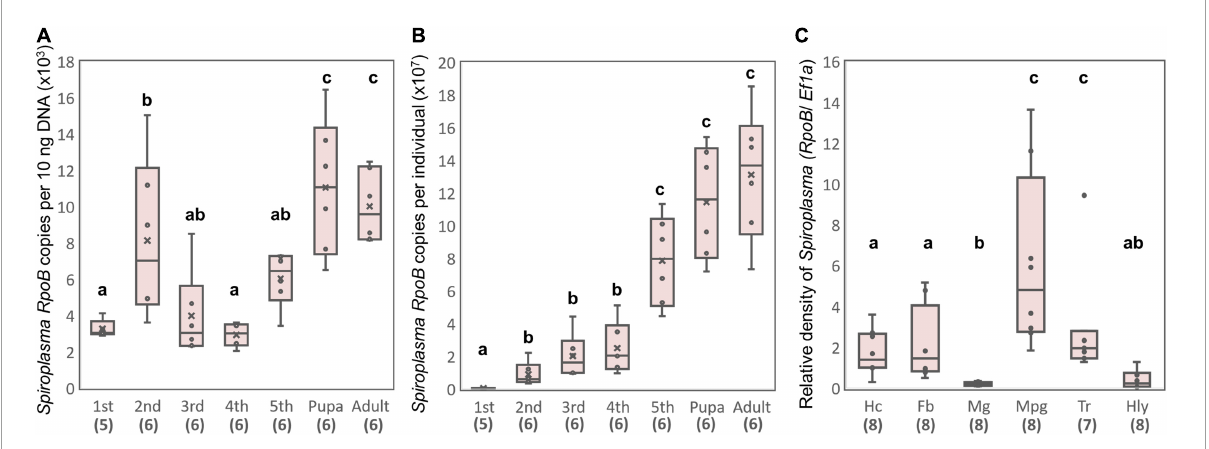
FIGURE5 Propagation and localization of strain s Hm in H. magnanima . Spiroplasma densities deduced from RpoB copy numbers per 10 ng DNA (A) and Spiroplasma densities deduced from RpoB copy numbers per individual (B) at each developmental stage. (C) Relative Spiroplasma density in